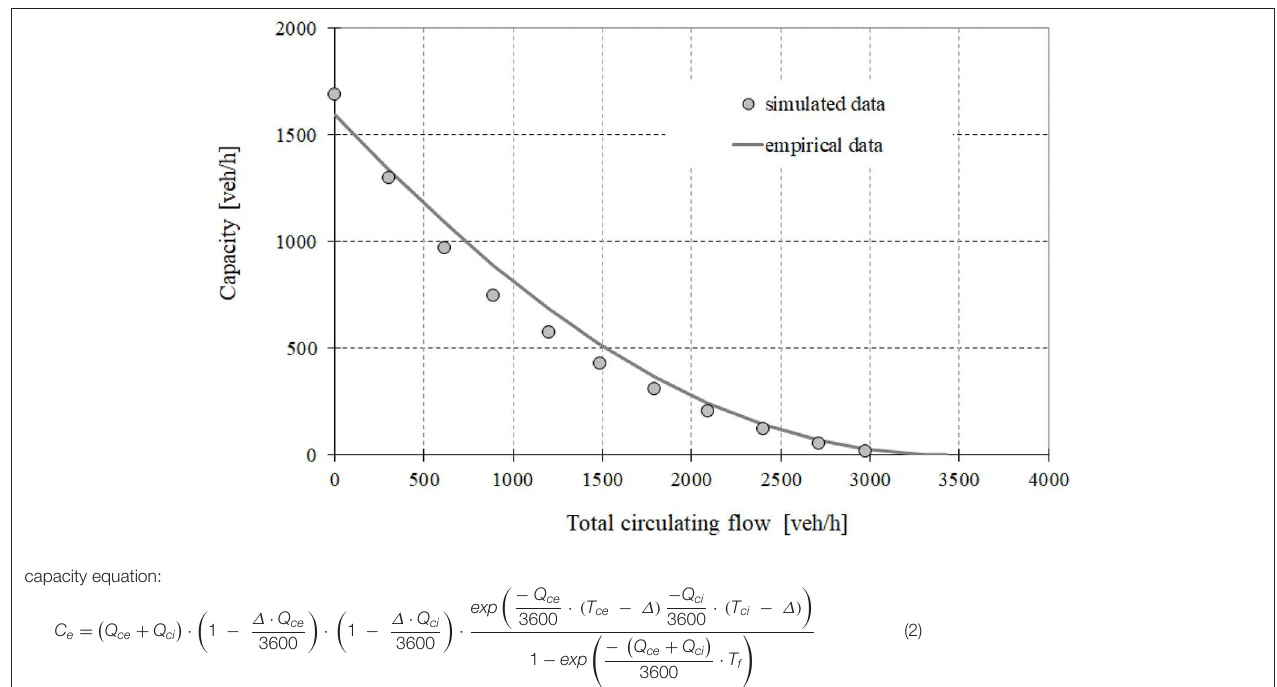
FIGURE 5 | Comparison of empirical and simulated data for left lane capacity at roundabout 2 ( Q ci /Q ce = 1). C e = capacity at entries [veh/h]; total circulating flow = (Q ce + Q ci ); Q ce , circulating flow (outside lane) [veh/h]; Q ci , circulating flow (inside lane) [veh/h]; 1 = 2.10s; T ci , critical headway (inside lane), s; T ce , critical headway (outside lane) [s]; T f , follow up headway